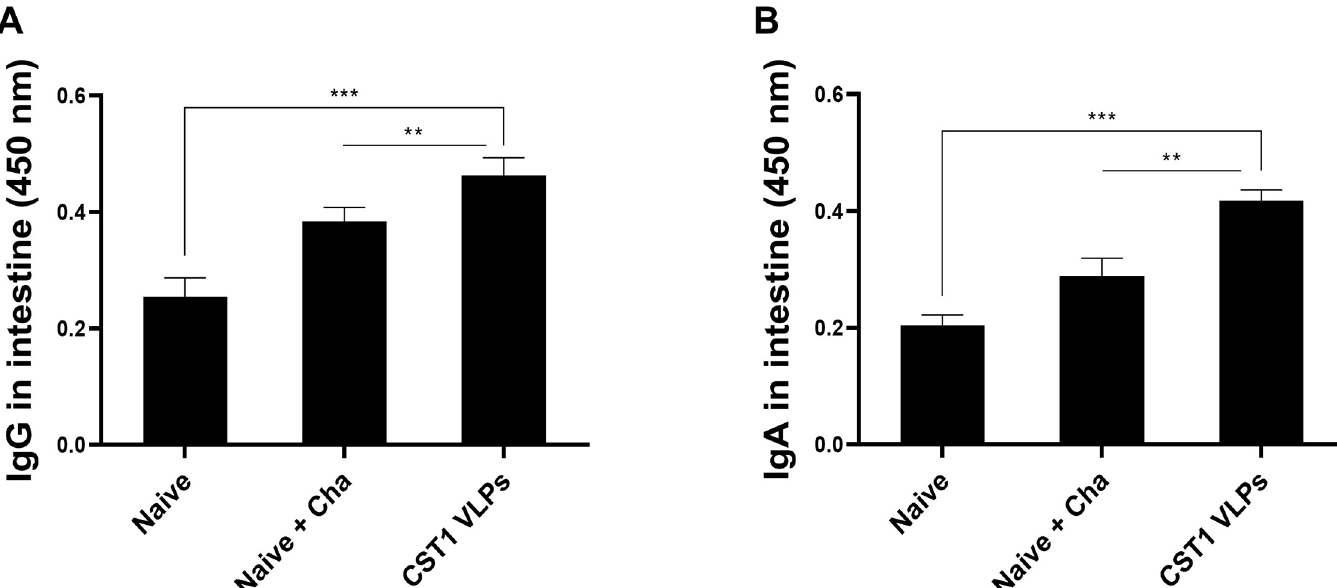
Fig 4. IgG and IgA in the intestine. Intestines of mice were collected after challenge infection with T . gondii ME49. Mucosal IgG (A) and IgA (B) antibody responses from the intestines were measured by ELISA. Absorbance values at 450nm were measured and data are shown as mean ± SD, with asterisks denoting statistical significance between the groups ( ** P < 0.01, *** P < 0.001). Mucosal samples were collected on an individual basis and data are representative of 3 independent experiments performed in